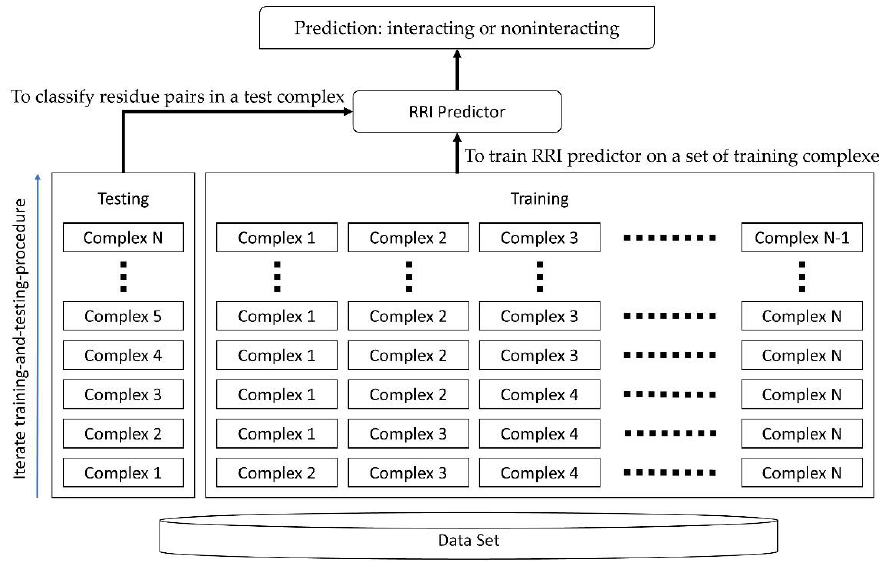
Figure 1. The training–testing process in LOOCV. Table 1. Average results for LOOCV on DBD 5.0.